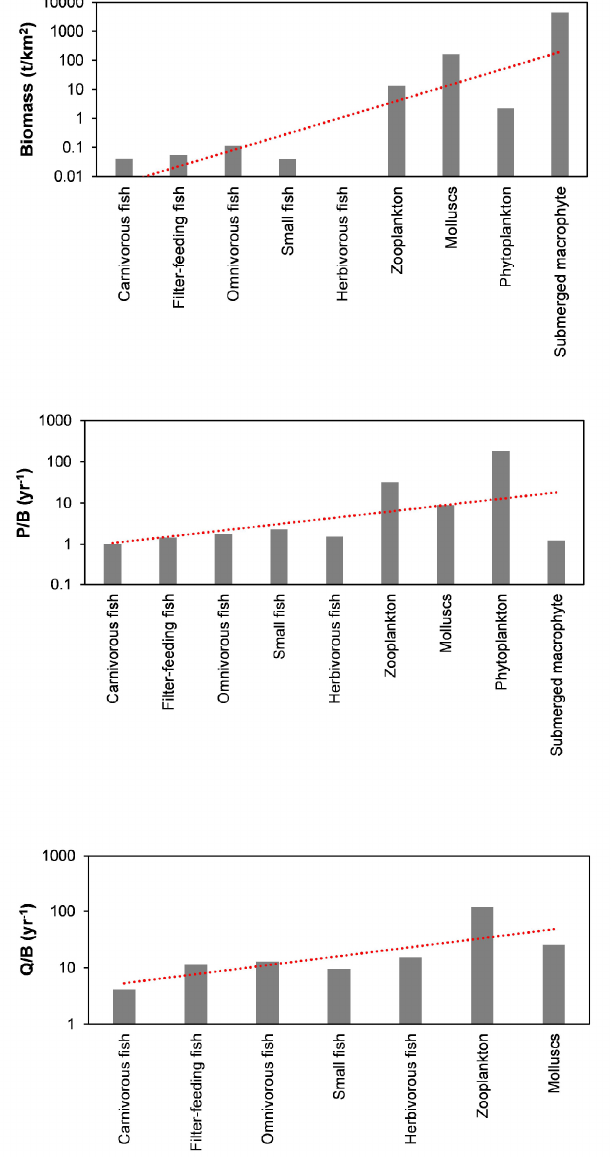
Figure 2. The PREBAL diagnostic analysis of input parameters (Biomass, P / B and Q / B). All y axis values are log-scaled whereas species on the x axis are ranked from highest to lowest trophic level. The red dotted line represents regression between trophic level and other values.